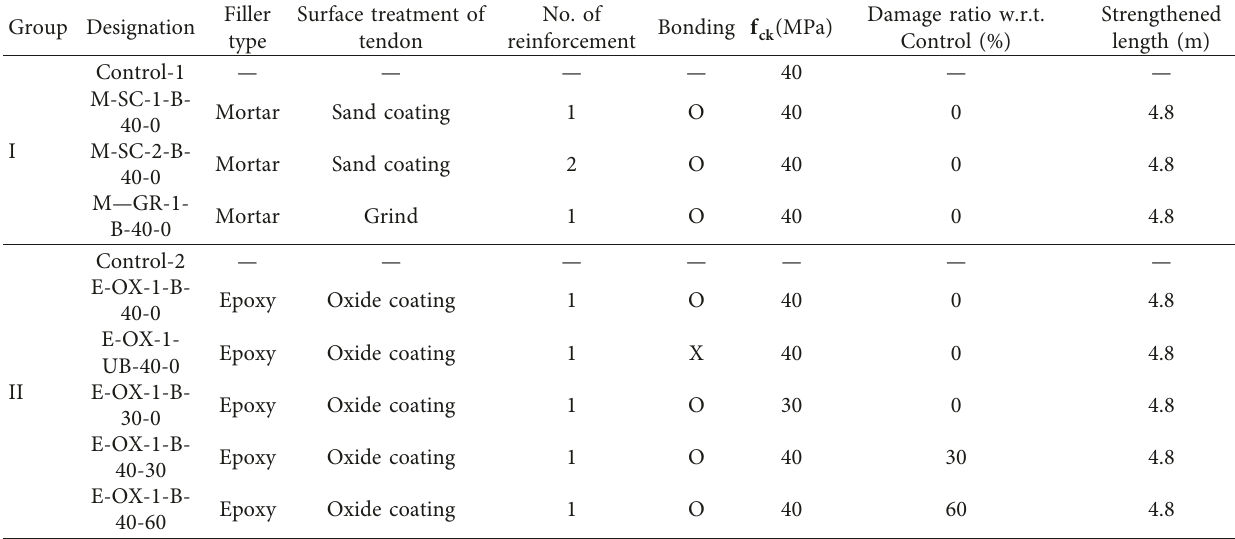
Table 4: Test variables and designation of specimens.